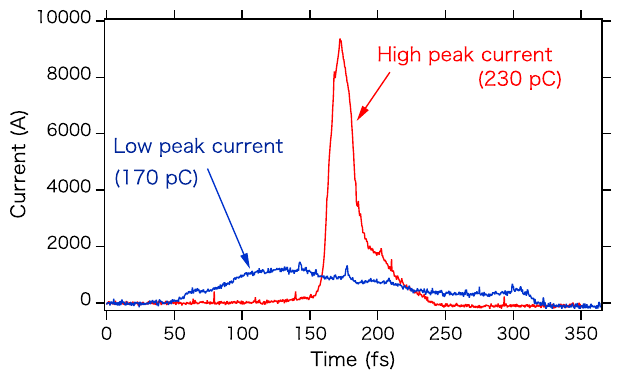
FIG. 7. Longitudinal current profiles of the electron bunch measured by a C-band rf deflector [15]. The profile shown in red is the electron bunch with a high peak current used for the normal operation of BL3. The profile shown in blue is the electron bunch with a low peak current obtained after parameter optimization for BL2.